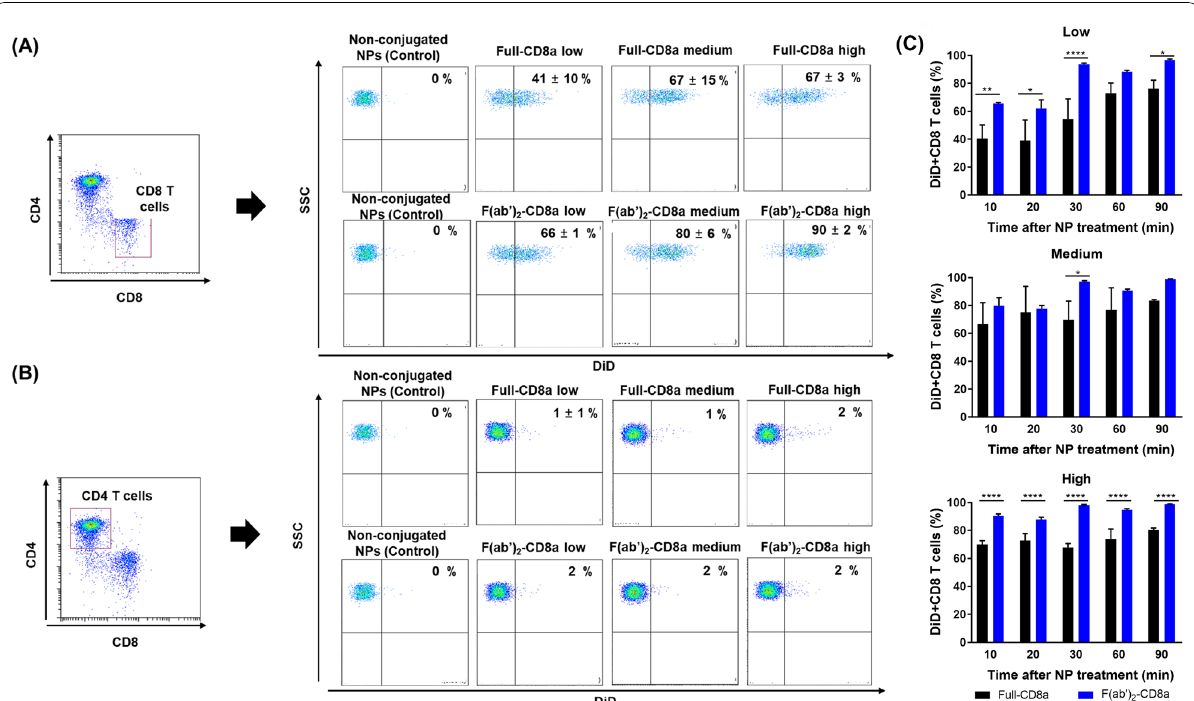
Fig. 3 T cell targeting efficiency of the CD8a‑conjugated NPs in vitro. A Binding of the anti‑CD8a conjugated NPs to the CD8a T cells. The mouse splenocytes were treated with the NPs for 10 min after loading the NPs with DiD and assessed through flow cytometry. B Observed DiD signal in the CD4 T cells that confirms the minimal non‑specific binding of the anti‑CD8a conjugated NPs, and (C) Comparison between the populations of the DiD‑expressing CD8 T cells induced by the full‑CD8a NPs and f(ab ′ ) 2 ‑CD8a NPs at different instants. Data were presented as the mean (n 3, * P 0.0332, ** P 0.0021, *** P 0.0002, **** P < = = = =